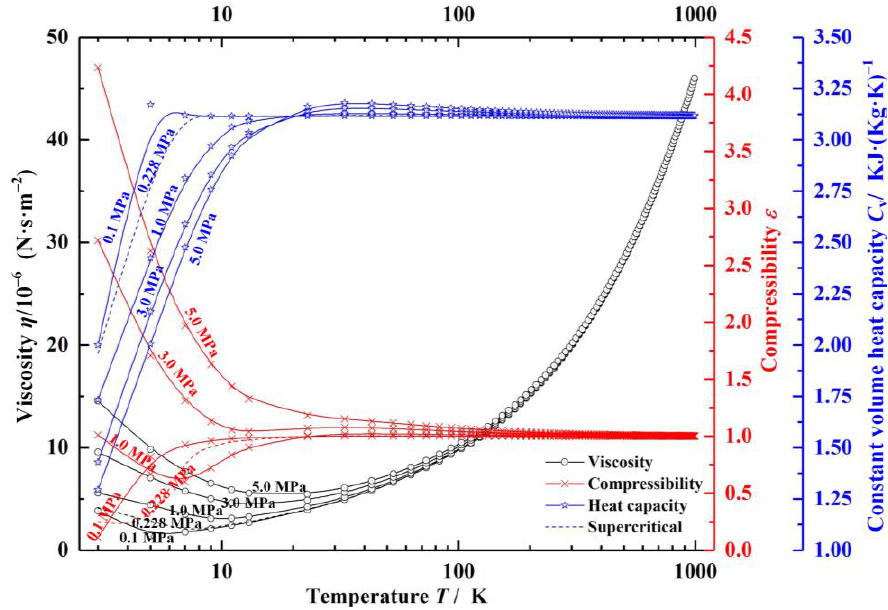
Figure 2. Variation of helium properties with different operating conditions.